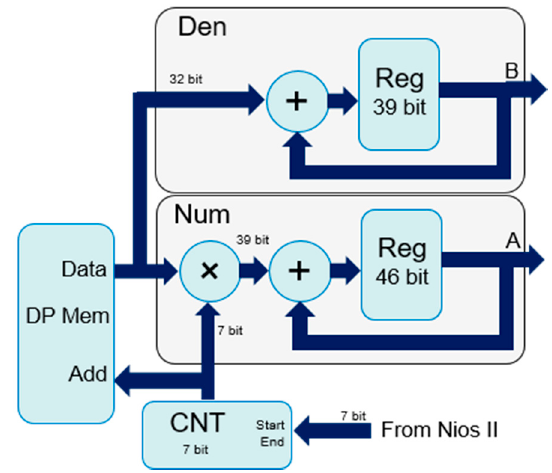
Figure 6. Details of the implementation of the Num and Den modules.